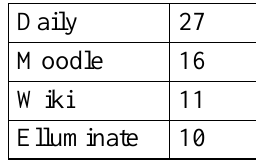
The Most Useful